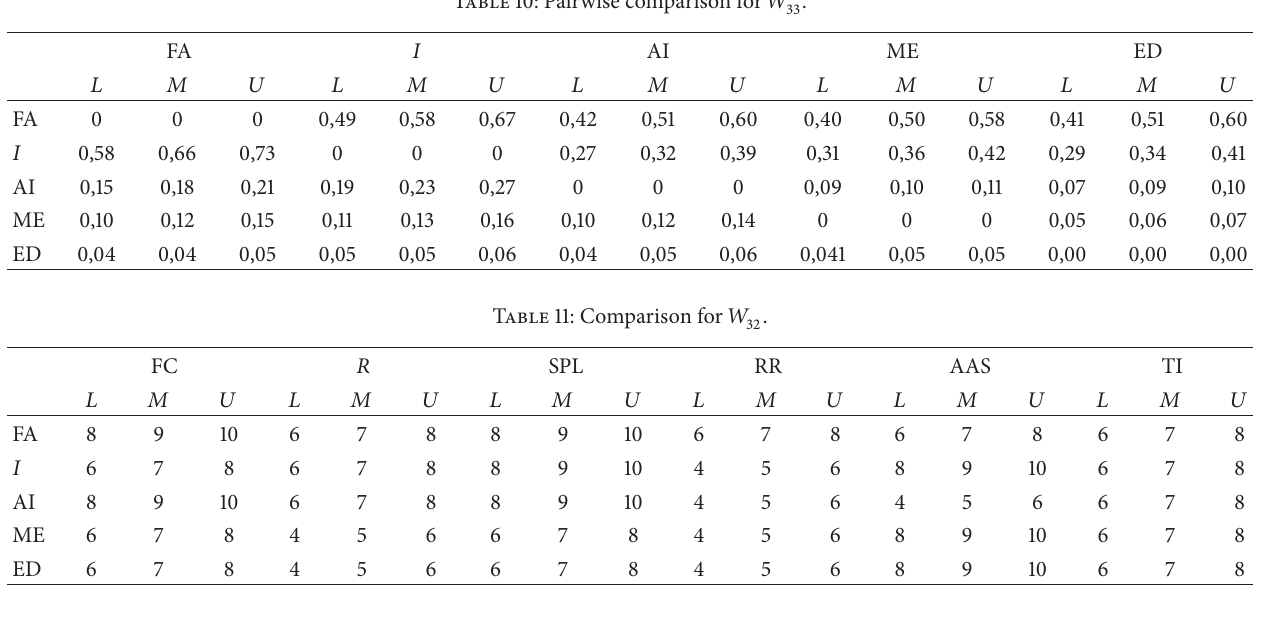
Table 12: Normalized 𝑊 32 .